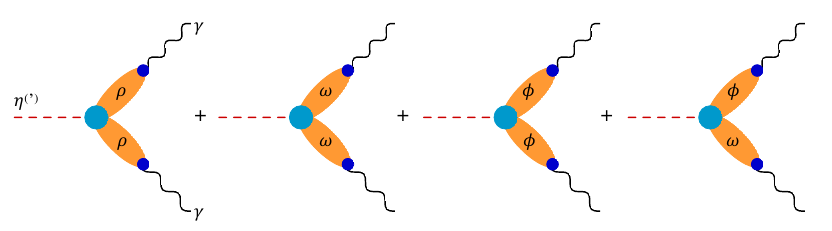
Figure 8. (cid:17) and (cid:17) 0 TFFs in the large- N c